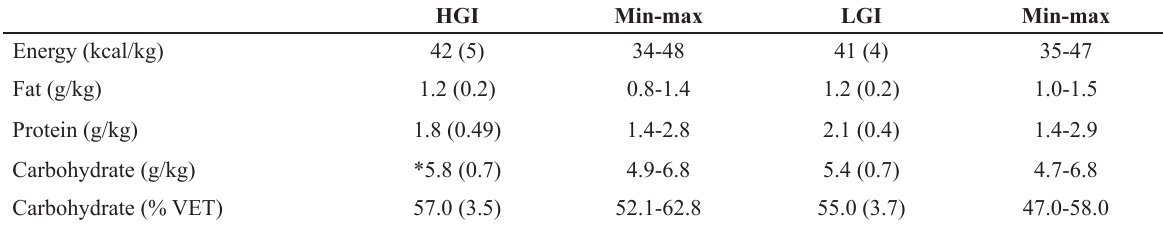
Daily dietary information according to the GI consumed at evening meals (n=9).